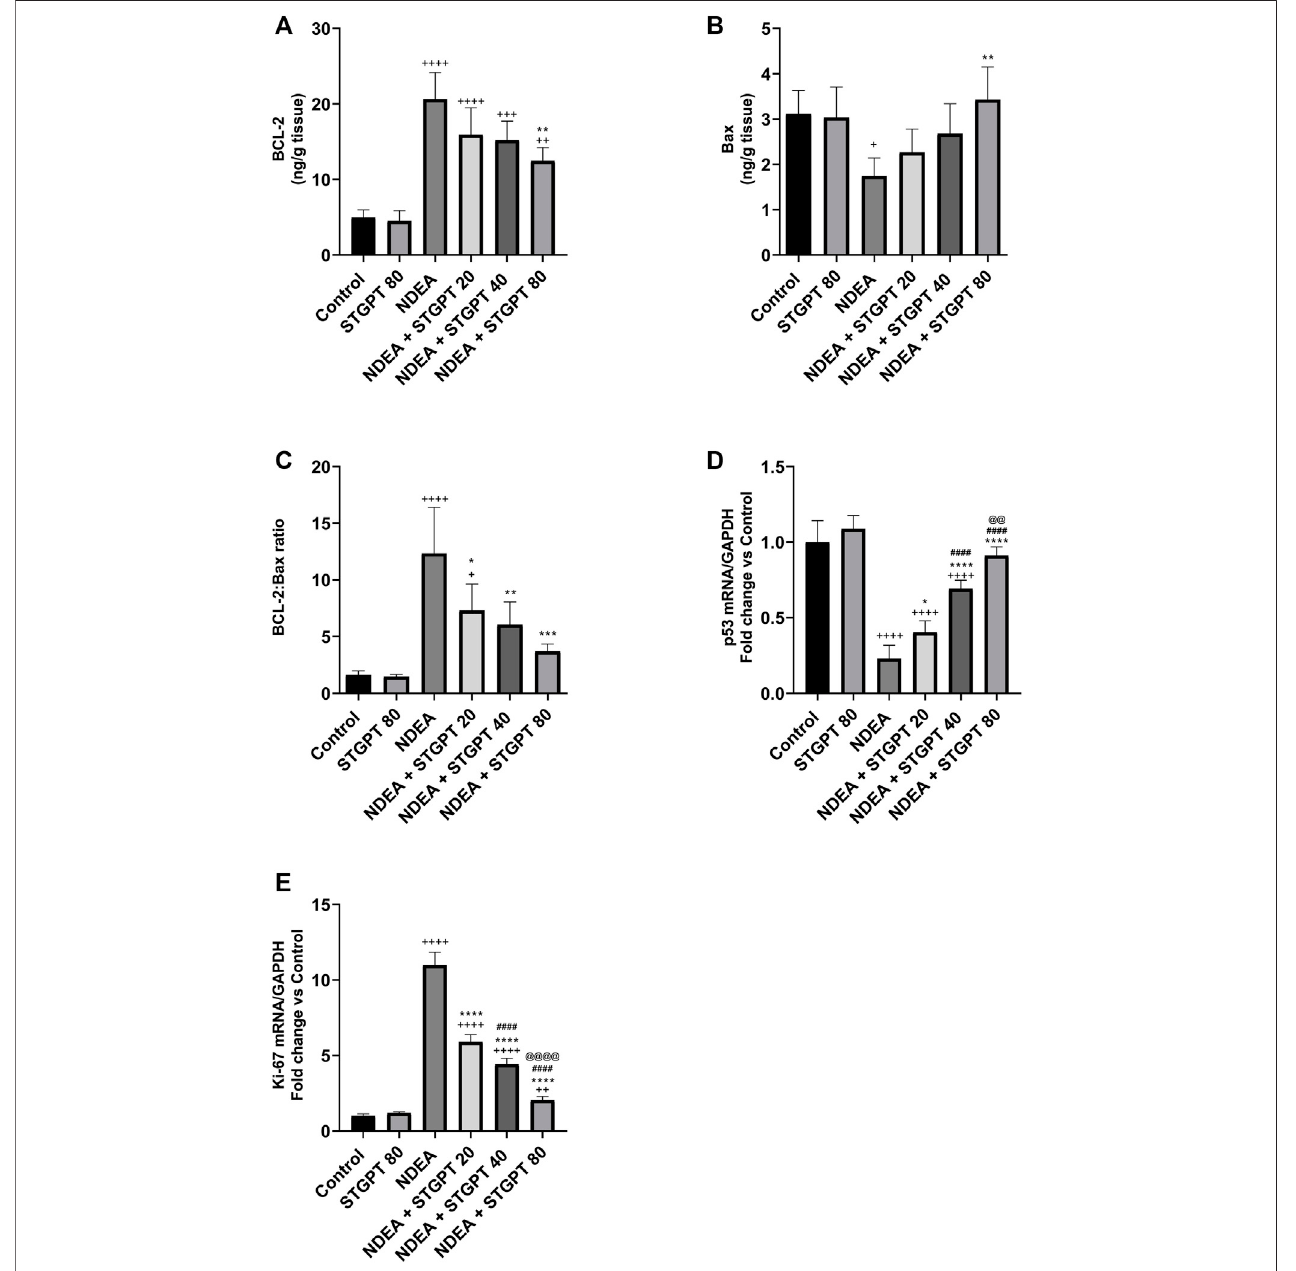
FIGURE8 | Effect ofSTGPT (20, 40and 80 mg/kg) onBCL-2 (A) ;Bax (B) ; BCL-2: Baxratio (C) ; p53 mRNA (D) ;and Ki-67 mRNA (E) in mice withNDEA-induced HCC. Dataarepresentedasthemean ± SD( n (cid:1) 6). + p < 0.05vsControlgroup, ++ p < 0.01 vs. Controlgroup, +++ p < 0.001 vs. Controlgroup, ++++ p < 0.0001 vs. Control group, * p < 0.05 vs. NDEAgroup,** p < 0.01 vs. NDEAgroup,*** p < 0.001 vs. NDEAgroup,**** p < 0.0001 vs. NDEAgroup, #### p < 0.0001 vs. STGPT20group, @@ p < 0.01 vs. STGPT 40 group, @@@@ p < 0.0001 vs. STGPT 40 group. Control, normal control group received the vehicle; STGPT 80, normal group received